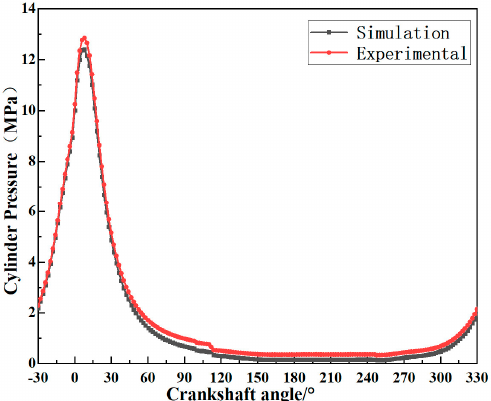
Figure 6. Comparison of simulation and test cylinder pressure.